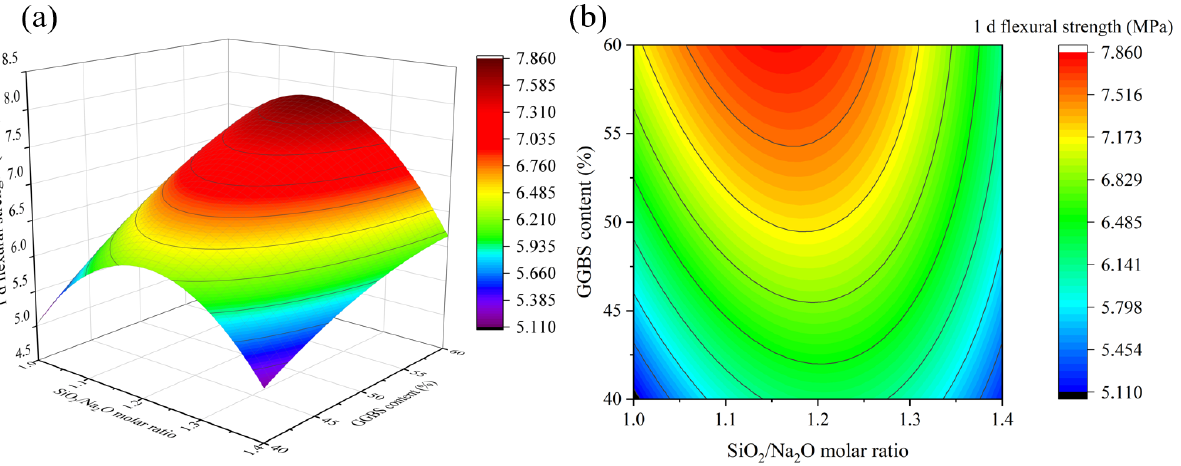
Figure 10 . The interaction effect of SiO 2 /Na 2 O molar ratio and GGBS content on 1 d flexural strength: ( a ) 3D response surface; ( b ) contour diagram.